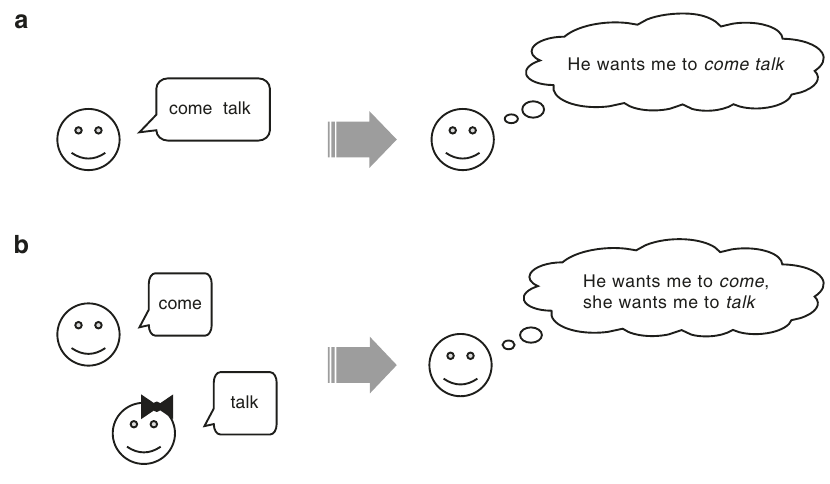
Fig.1|Experimentalparadigmfortestingcore-Merge.a Inlanguage,core-Merge allows receivers to recognize two temporally liked words as a single unit (e.g., “ come ” + “ talk ” ={cometalk}). b However,ifthesamewordsareseparatelygivenby twopersons,receiversmayperceivethemastwoindividualmessages(e.g., “ come ”